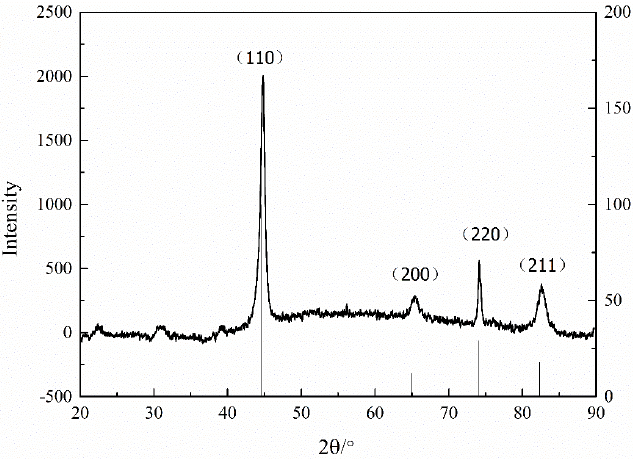
Figure 9. The effect of saccharin sodium on the surface morphology. ( a ) without saccharin sodium, ( b ) with saccharin sodium.